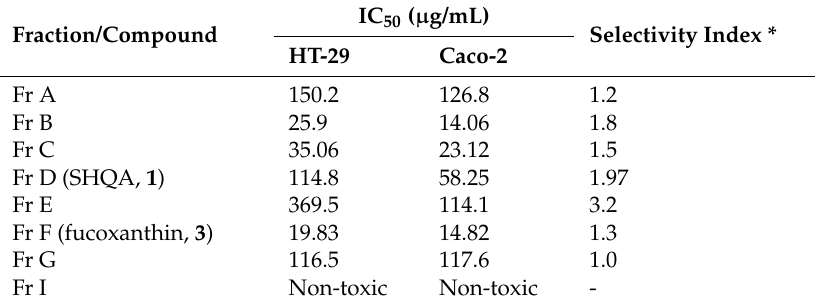
Table 2. Cytotoxicity of S. incisifolium fractions against proliferating HT-29 and Caco-2 cells. IC 50 values as determined using MTT viability assay after 48 h of